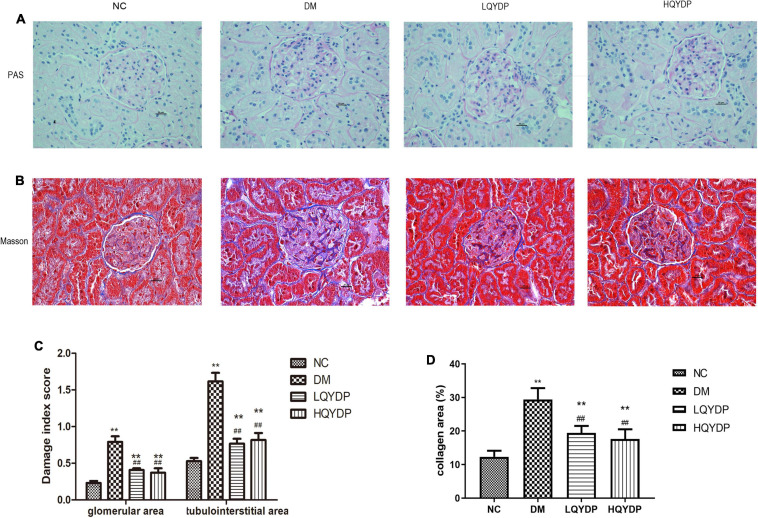
Effect of QYDP on histopathological changes in renal tissues of diabetic rats. (A) PAS stained kidney sections taken from rats in each group (400 × magnification), (B) Masson-stained kidney sections taken from rats in each group (400 × magnification), (C) glomerular and tubulointerstitial damage index score analysis with PAS staining. (D) Quantitative assessments of Masson-positive area (%) with Masson staining. Values are mean ± SD (n = 6); **p < 0.01 compared with NC group; ##p < 0.01 compared with DM group. QYDP, Qishen Yiqi dripping pill; NC, normal control; DM, diabetes mellitus; LQYDP, low dose of Qishen Yiqi dripping pill; HQYDP, high dose of Qishen Yiqi dripping pill.